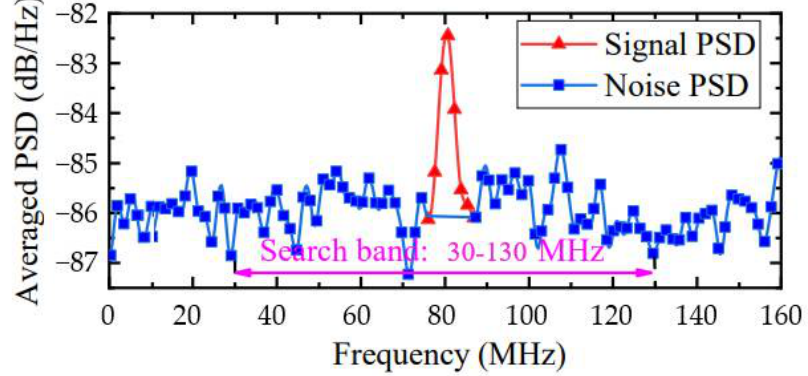
Figure 5. The method of calculating the CNR of the range gate division of the Lidar.